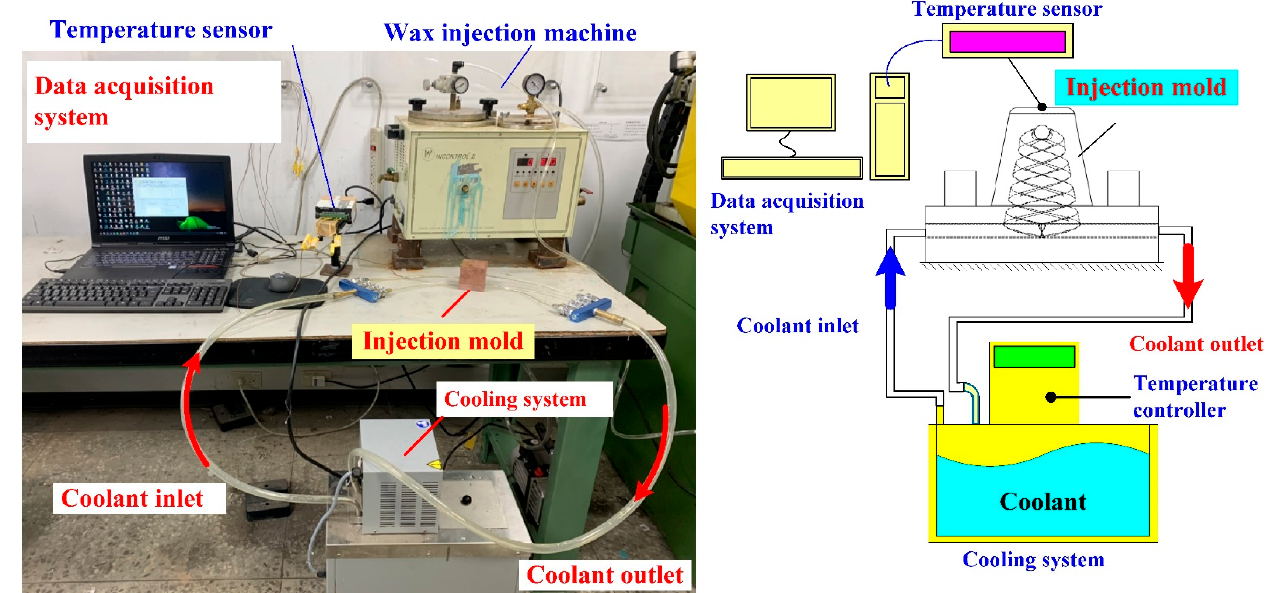
Figure 9. An in-house cooling time measurement system.